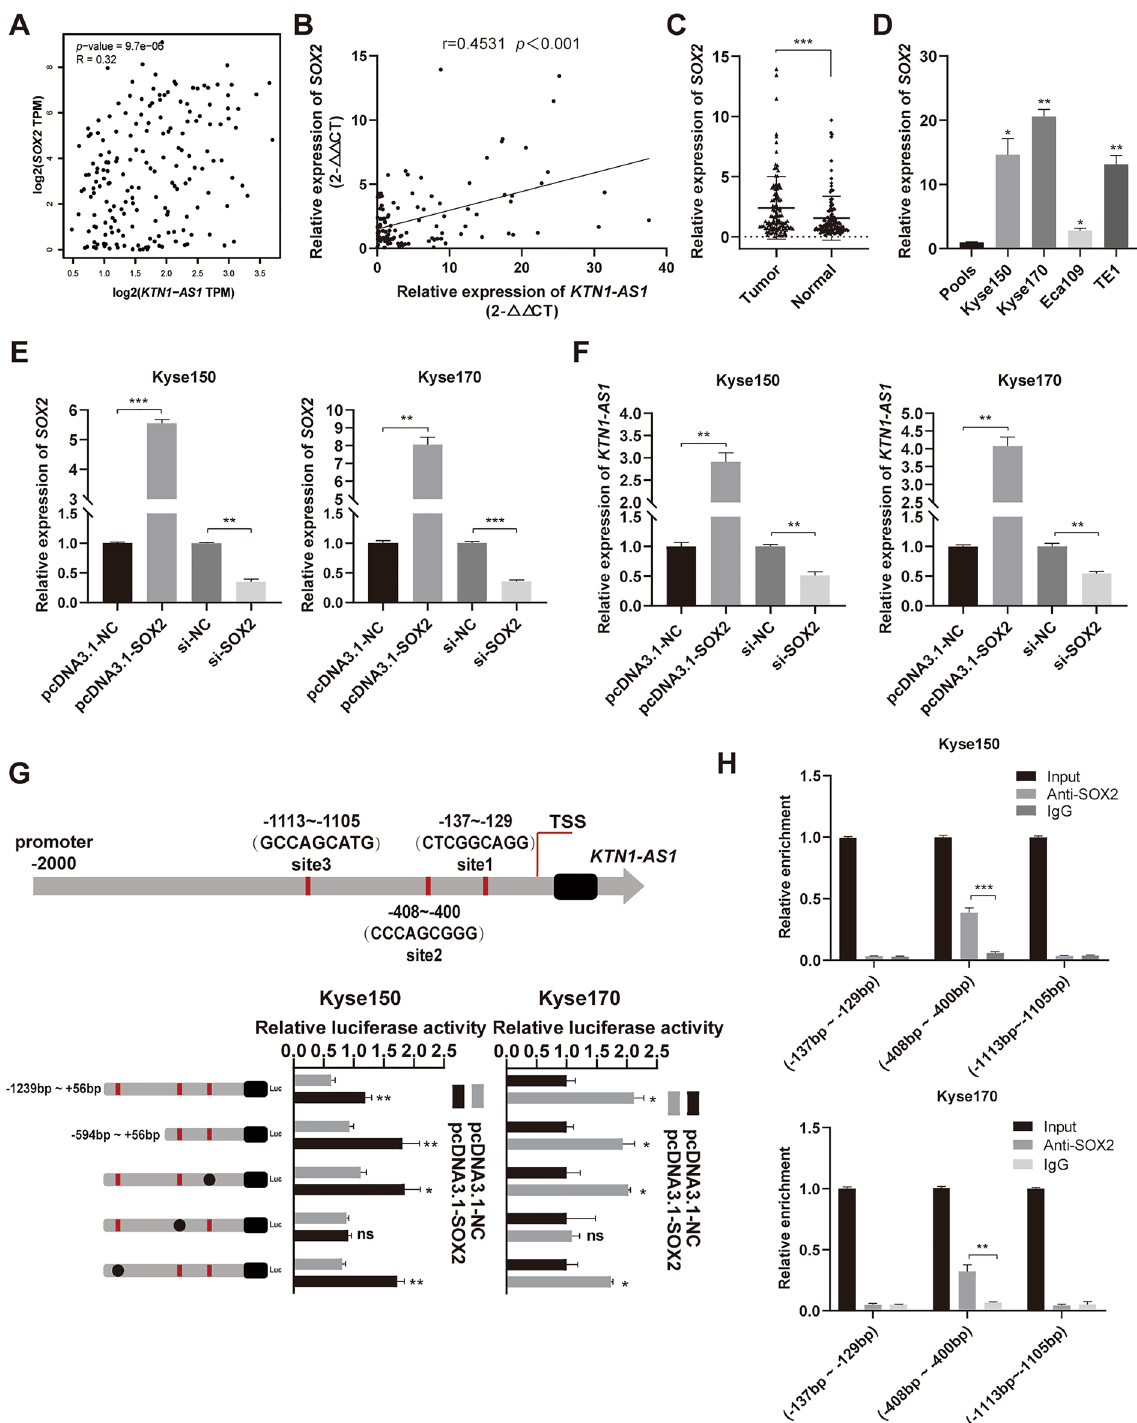
Figure 2. SOX2 induces KTN1-AS1 expression in esophageal squamous cell carcinoma (ESCC) cells. ( A ) The relevance of expression between KTN1-AS1 and SOX2 was analyzed by the Gene Expression Profiling Interactive Analysis (GEPIA) database. ( B ) The correlation between the expression of KTN1-AS1 and SOX2 was analyzed by qRT-PCR method. ( C ) The expression levels of SOX2 in ESCC and the corresponding normal tissues were detected by qRT-PCR method. ( D ) The expression levels of SOX2 in human ESCC cell lines. ( E ) The overexpression and knockdown efficiency of SOX2 in Kyse150 and Kyse170 cells were detected by qRT-PCR method. ( F ) The regulation effect of SOX2 on KTN1-AS1 expression in Kyse150 and Kyse170 cells were detected using qRT-PCR method. ( G ) Luciferase activity assay was conducted in Kyse150 and Kyse170 cells to verify the direct binding of SOX2 to the KTN1-AS1 promoter. ( H ) Chromatin Immunoprecipitation (ChIP) assay was used to confirm the binding site of SOX2 on the promoter of KTN1-AS1 in Kyse150 and Kyse170 cells. Error bars are shown as mean ± SD from three replicate experiments (n = 3) (* P < 0.05, ** P < 0.01, *** P <